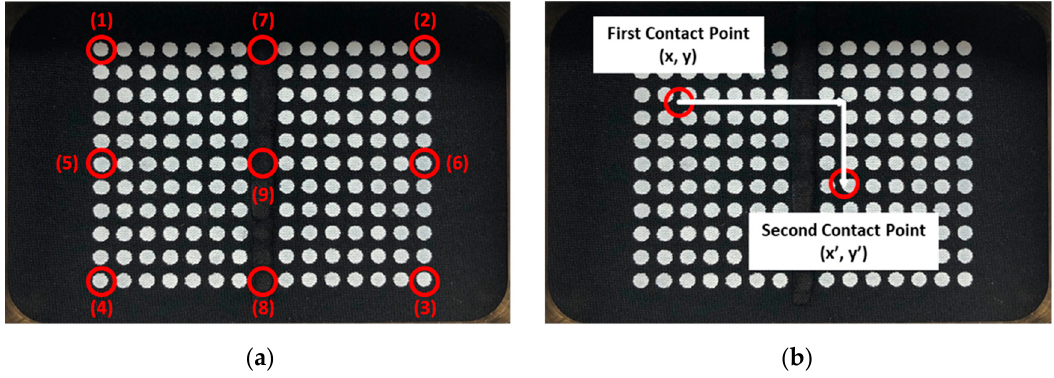
Figure 15. Experiment method of IASTS. ( a ) 1st experiment rule ( b ) 2nd experiment rule.